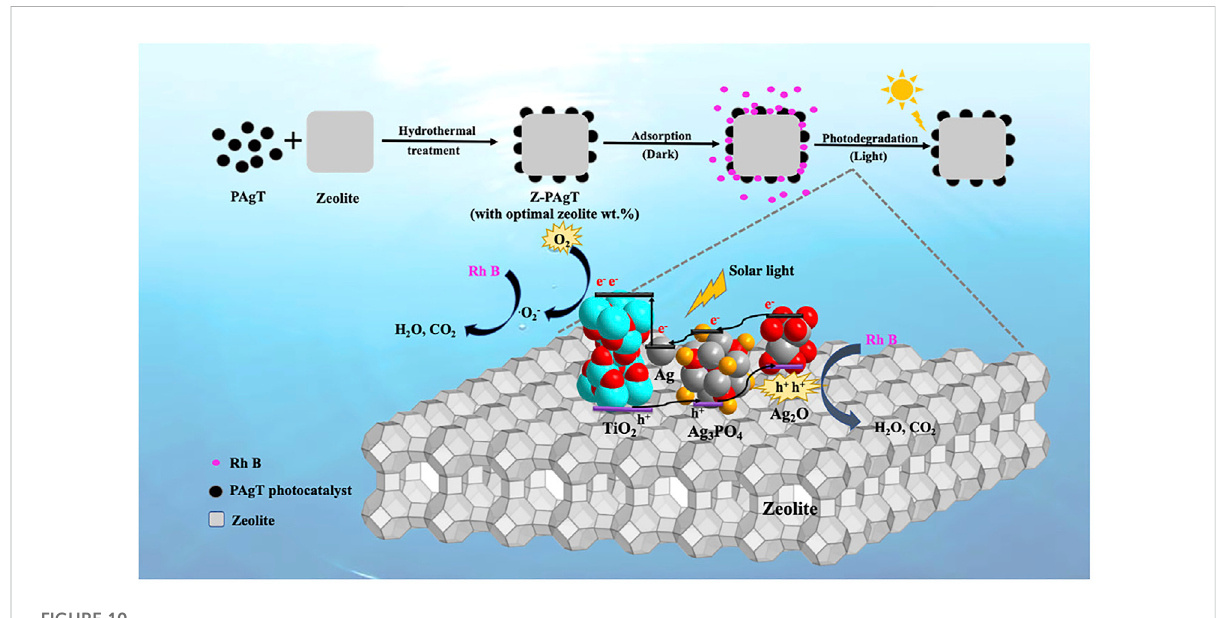
FIGURE 10 Proposed mechanism of Z-PAgT-5 composite for Rh B degradation under simulated solar